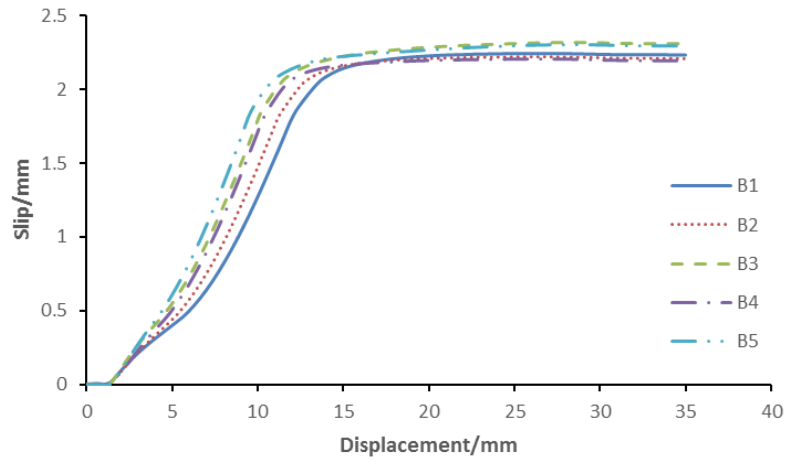
Figure 21. Slip-displacement curves.